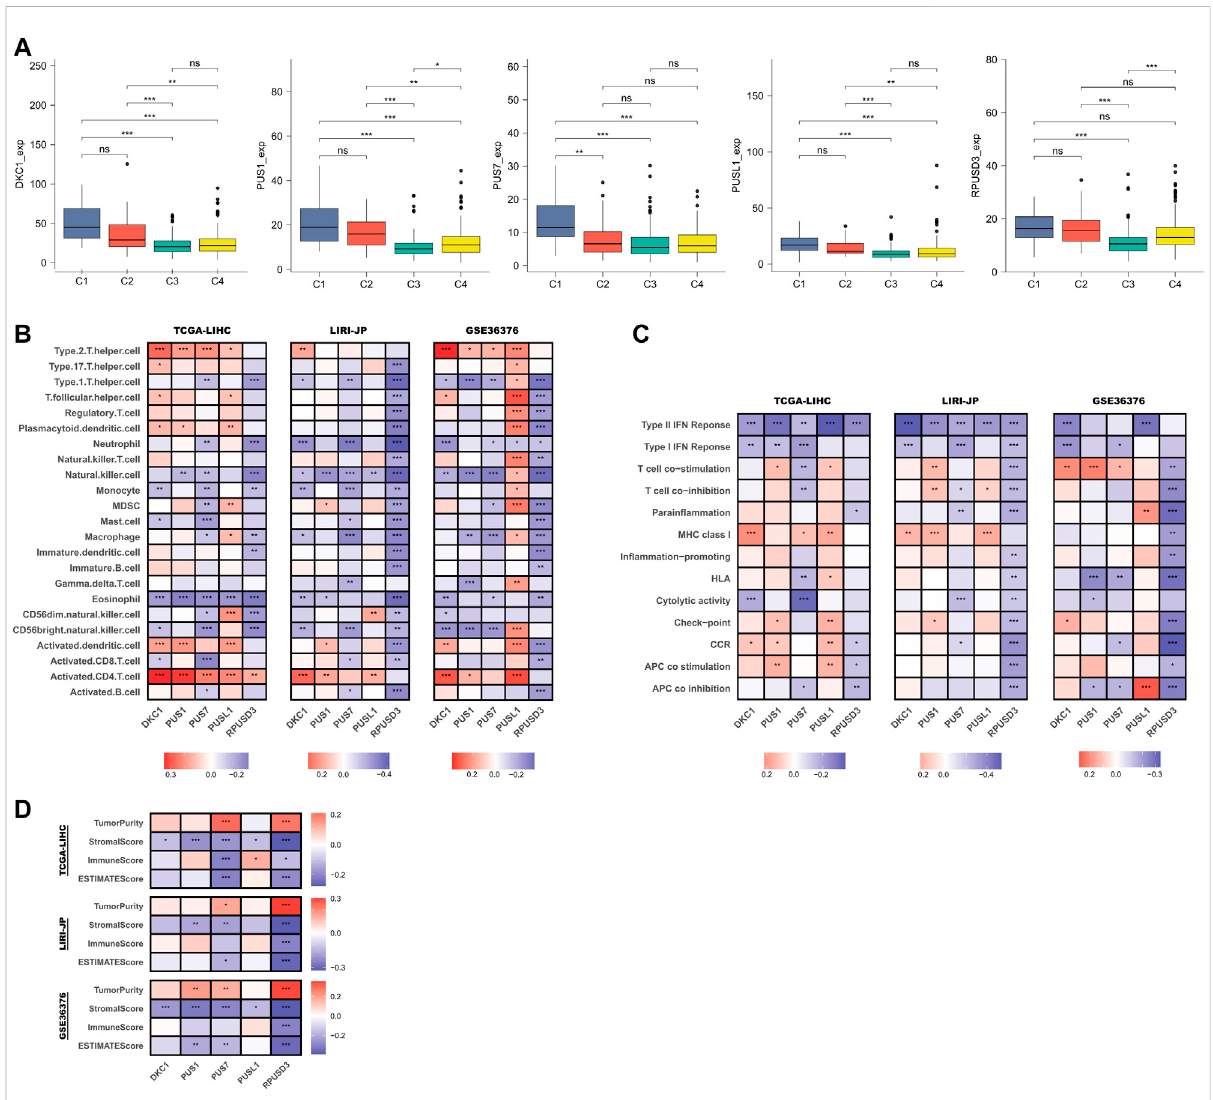
FIGURE 7 Relationship between PUSs and TME. (A) Differences in PUSs expression in HCC tissues of different immune subtypes; (B) Correlation of PUSs expression with the estimated abundance of immune cells; (C) Correlation of PUSs expression with the estimated activity of immune functions; (D) Correlation of PUSs expression with ESTIMATE score and estimated tumor purity. (ns: no statistical signi fi cance, * p < 0.05, ** p < 0.01, and *** p <